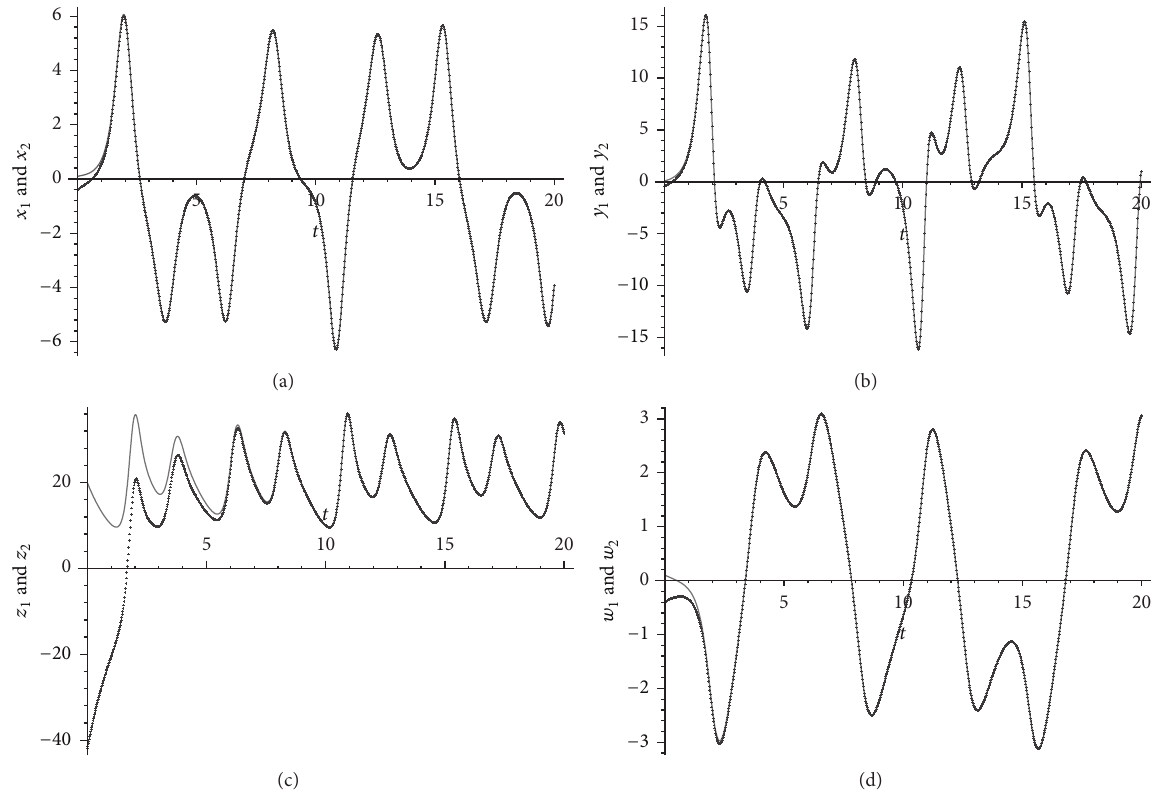
𝑦 2 (the solid line). (c) Signals